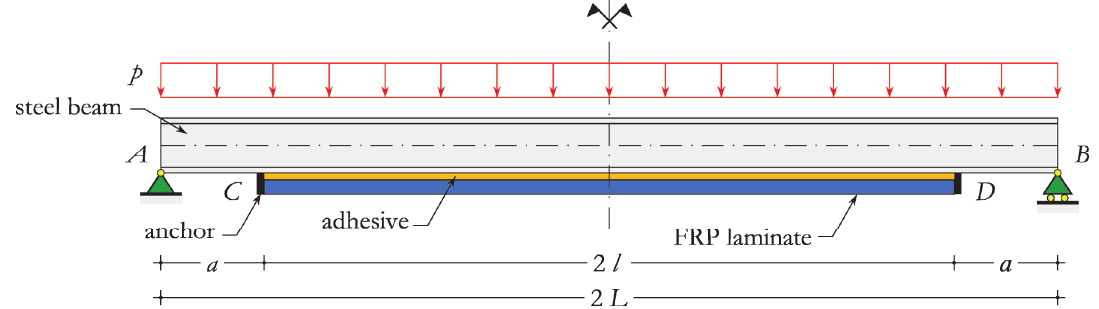
Figure 1: FRP-strengthened steel beam subjected to uniformly distributed